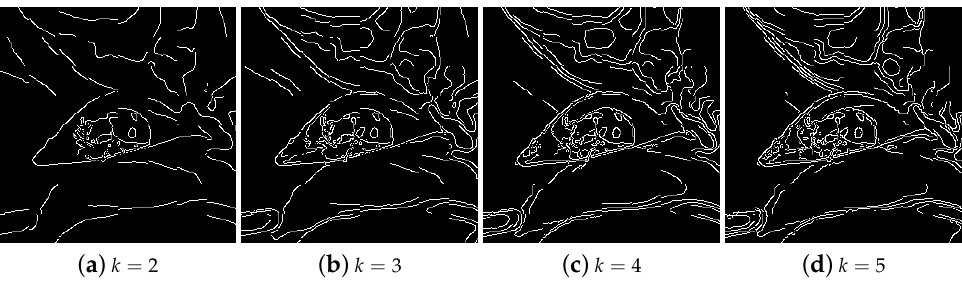
Figure 6. Edges detected by the local k-Means algorithm with different area (subimage) size.